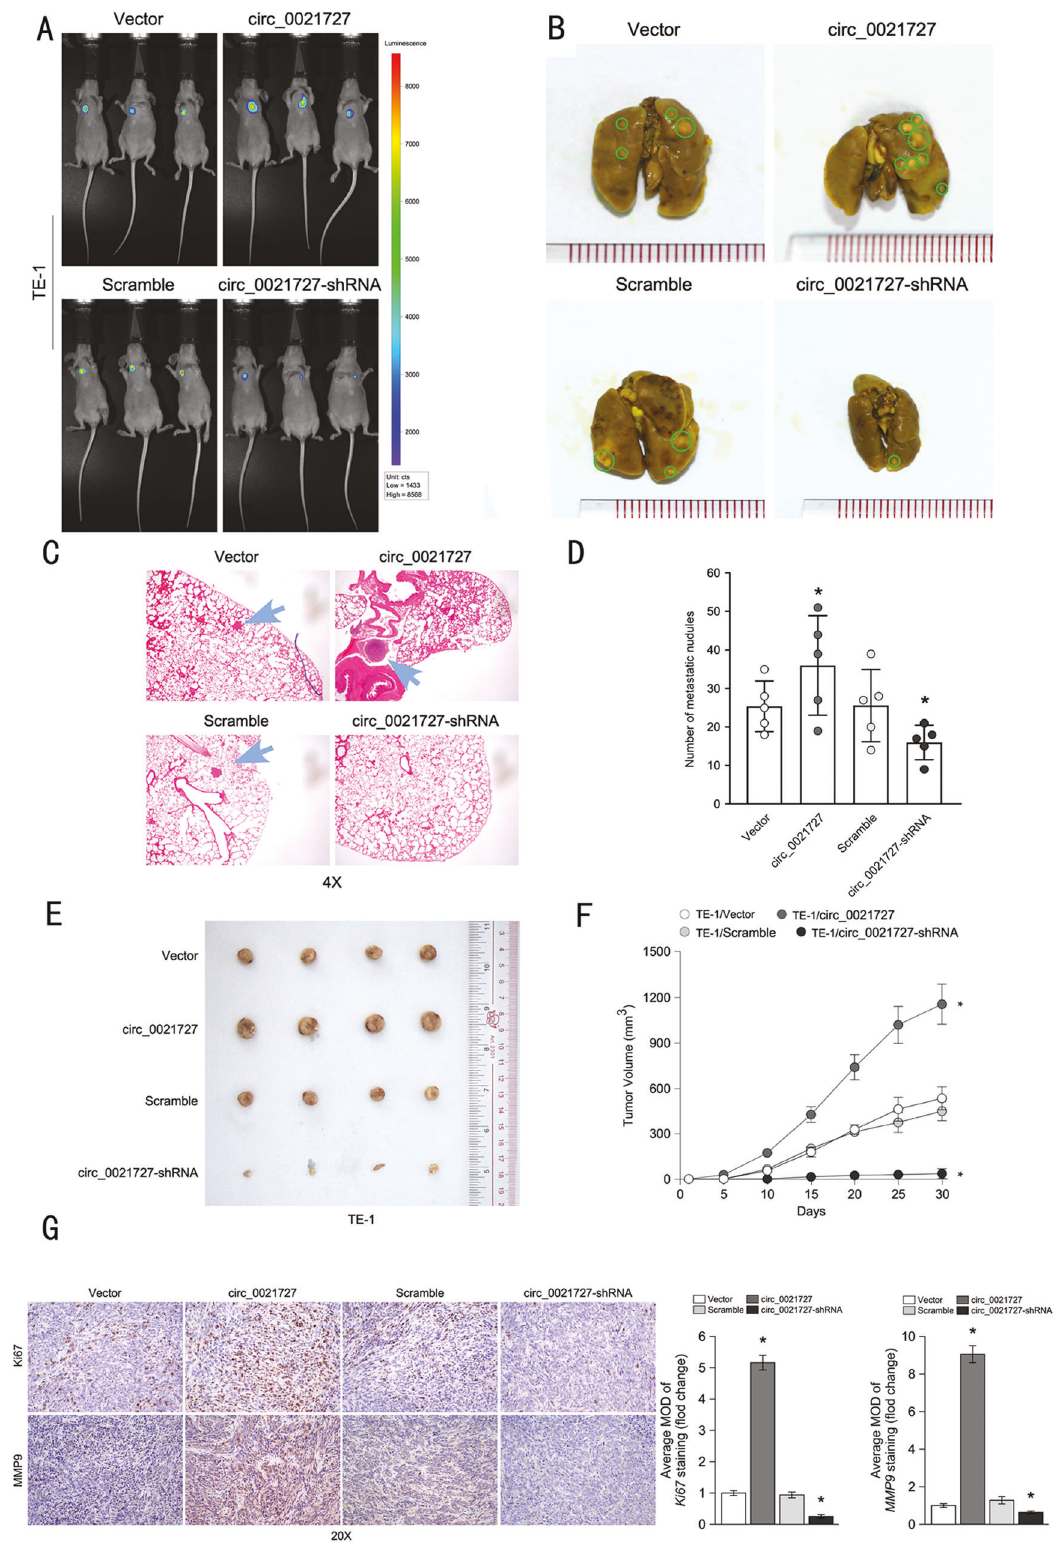
Fig. 3 Hsa_circ_0021727 promotes the metastasis and proliferation of ESCC cells in vivo. A Representative images and analysis of luminescence intensity in tail vein tumor metastasis mouse models. B Images of lung tissue in tail vein tumor metastasis mouse models. C Lung tissue was stained with HE. D Statistical analysis of lung metastatic nodules. E Representative image of a subcutaneous xenograft tumor. F Growth curves of tumor volumes in subcutaneous xenograft tumors models. G Immunohistochemistry showing the expression of Ki- 67 and MMP9 in mouse tumor tissues (values are expressed as the means ± SD; * P < 0.05).